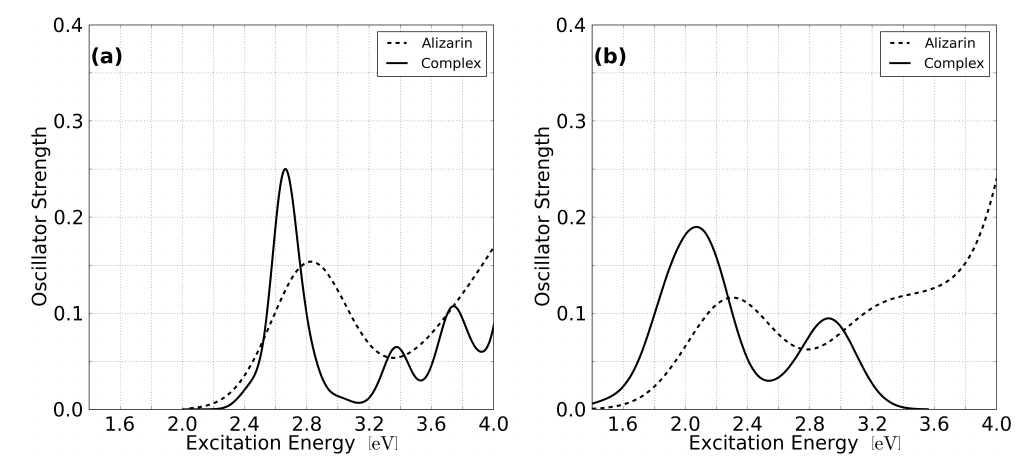
) complex obtained 2 15